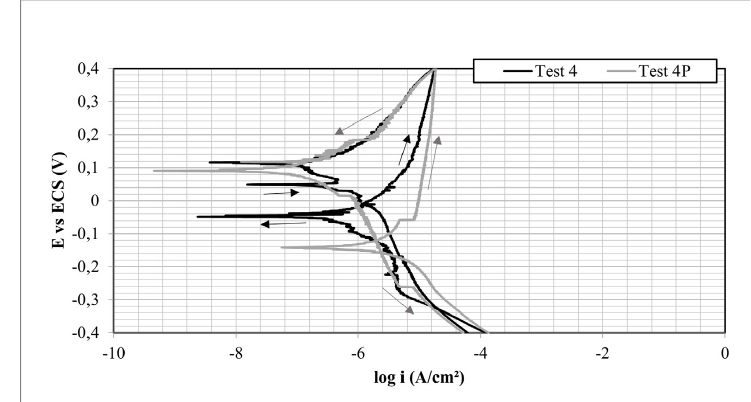
Figure 15. Cyclic voltammetric curves for tests 4 and